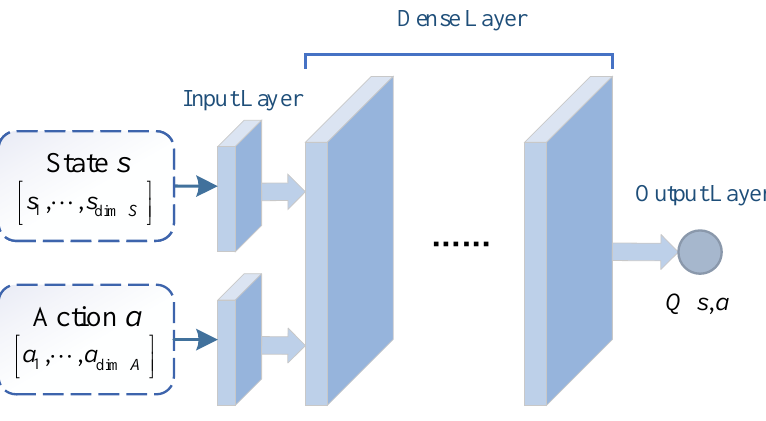
Figure 6. The structure of critic